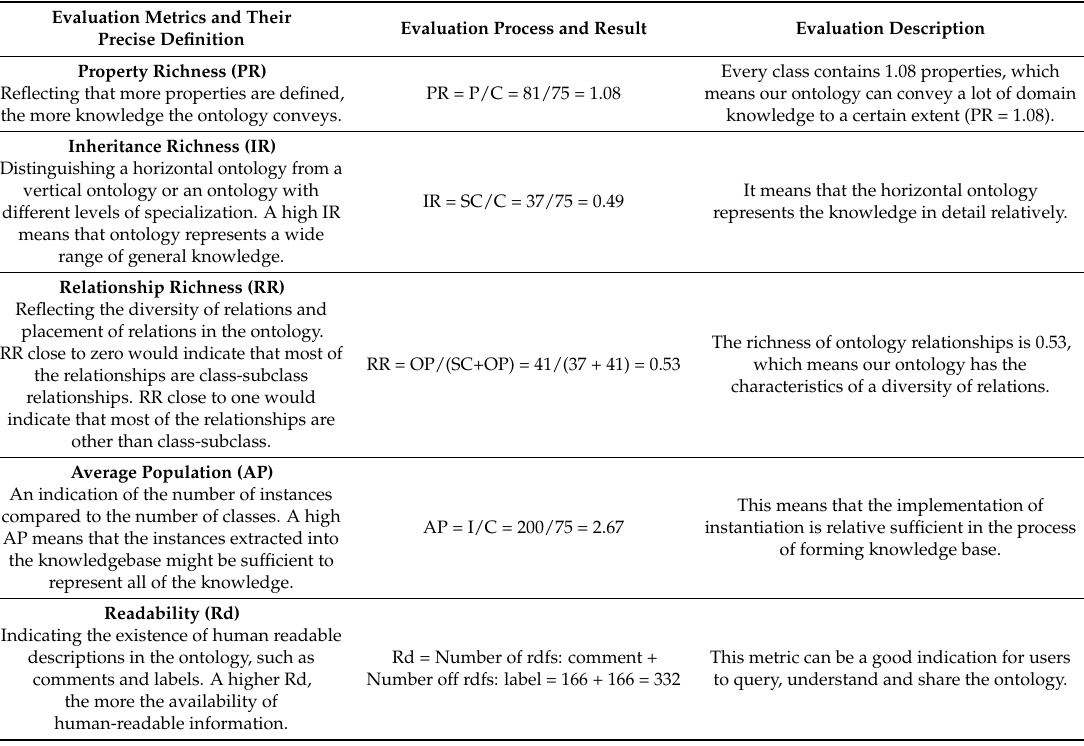
Table 3. Self-evaluation of SOCA ontology based on OntoQA